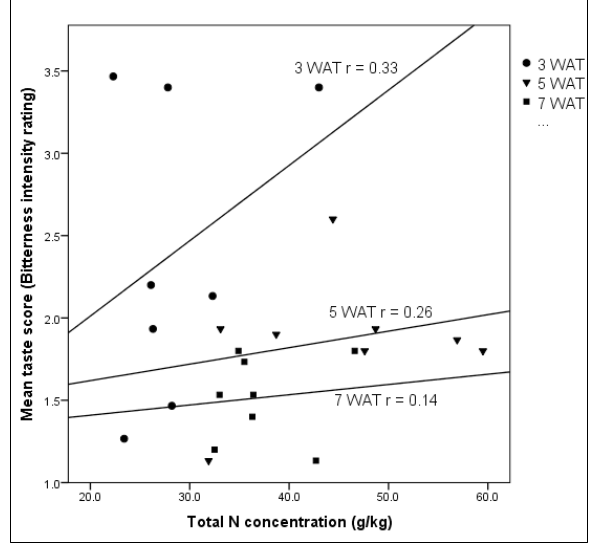
WAT, weeks after transplanting Figure 5: Relationship between total N content and mean taste scores of oilseed rape ( Brassica napus L.). Selected soil chemical properties during growth of oilseed rape Soil pH ranged from 6.0 to 7.1 and did not significantly ( p >0.05) vary across treatments at 3 WAT, although at 9 WAT it was significantly ( p <0.05) higher with 20 and 40 t/ha TSC-CM (Table 5). The alkaline nature of TSC-CM (Table 1) most likely contributed to the increase in soil pH and this was desirable as the sandy soils in the study area are prone to acidity and increased risk of induced nutrient deficiencies. 46